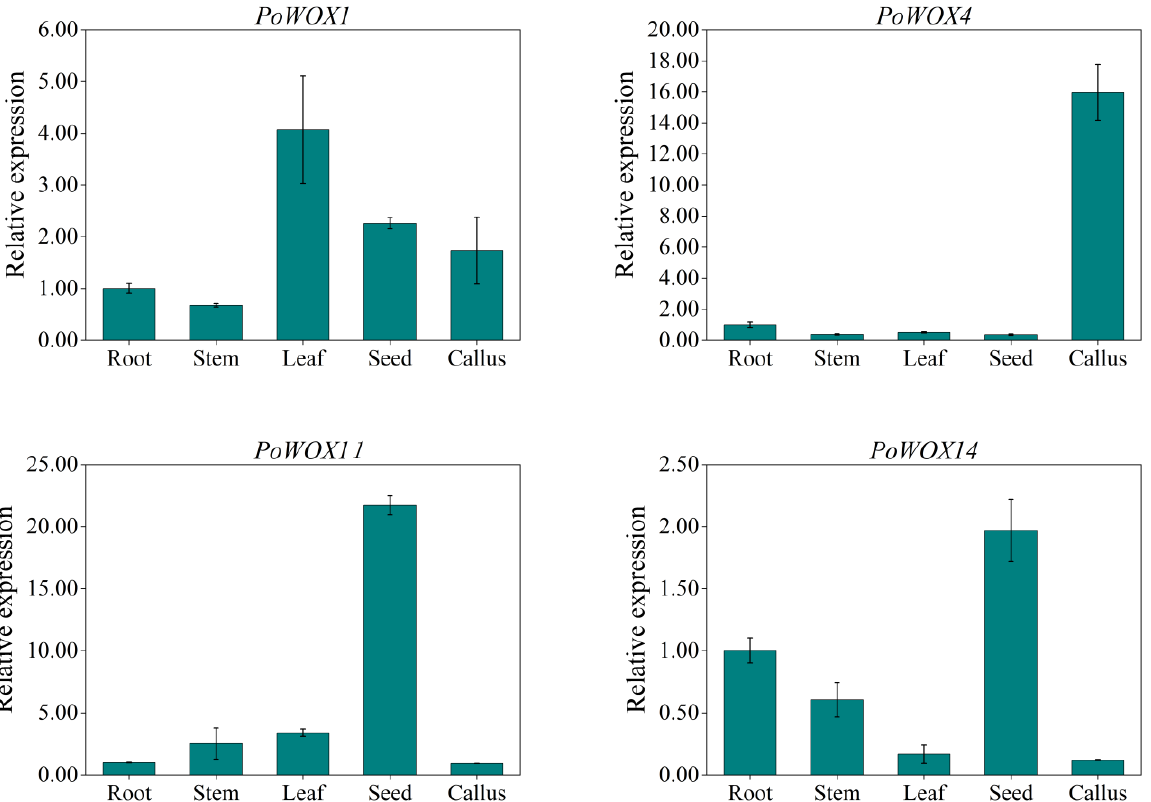
Figure 5. Expression of PoWOX genes in peony tissues. The expression of PoWOX gene in five different of peony (seed, root, stem, leaf, and callus). The expression of peony root tissues was the control group, respectively.